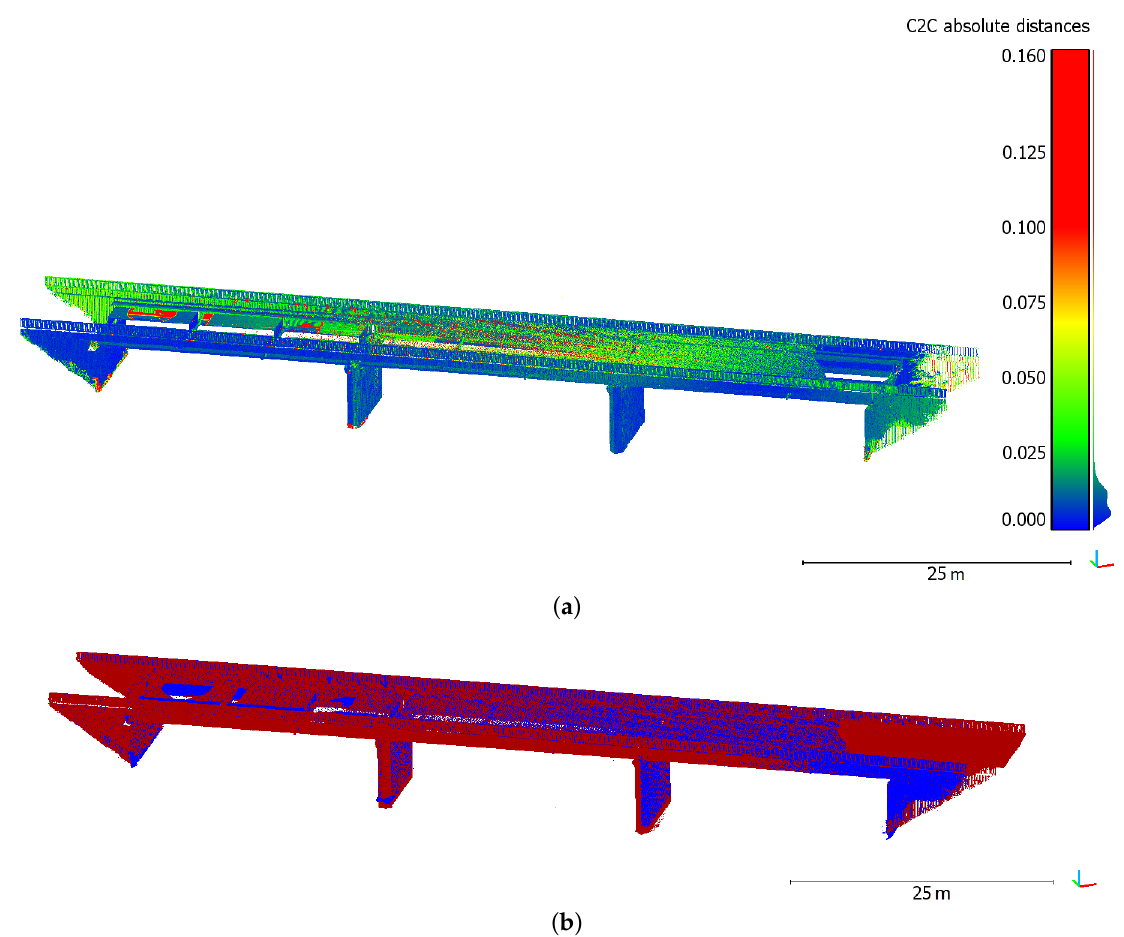
Figure 7. ( a ) Cloud-to-cloud comparison between Leica C10 and Trimble SX10 directly georeferenced point clouds of the bridge. Deviations (in m) are projected on SX10 point cloud; ( b ) Overview of both Leica C10 (in red) and Trimble SX10 (in blue) point clouds displayed